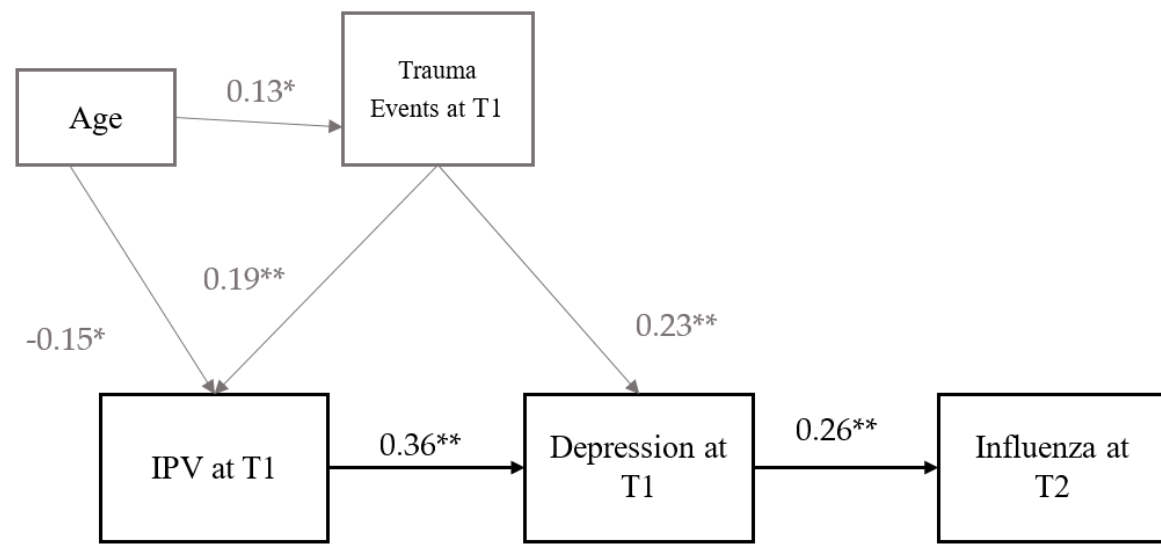
Figure 2. Path diagram including standardized significant direct path co-efficients. * indicates path co-efficient is significant at p < 0.05; and ** indicates path co-efficient is significant at p < 0.01.